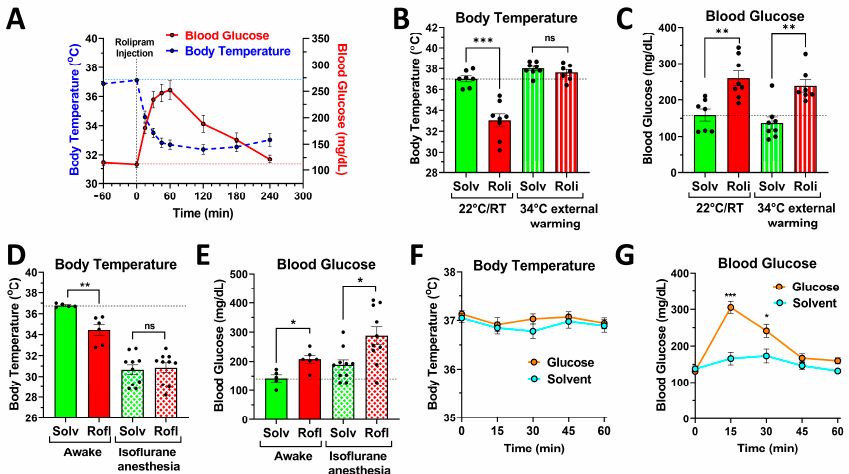
Figure 3. Transient hypothermia and hyperglycemia are independent effects of PAN-PDE4 inhibitor treatment. ( A ) Treatment with a PAN-PDE4 inhibitor induces acute hypothermia, as well as hyperglycemia, on similar time courses. Postprandial mice were injected with the PDE4 inhibitor rolipram (5 mg/kg; i.p.; n = 12) and blood glucose levels (red/solid line) and body temperature (blue/striated line) were measured at the indicated time points. ( B , C ) External warming prevents PDE4 inhibitor-induced hypothermia, but not increased blood glucose levels. After 5 h of food deprivation, mice were acclimated to cages maintained at room temperature (22 °C; solid bars) or to cages externally warmed to 34 °C using an electric heater (striated bars). Mice were then injected with rolipram (Roli; 5 mg/kg; i.p.) or the solvent control (Solv), and body temperature ( B ) and blood glucose levels ( C ) were assessed 30 min later. ( D , E ) Isoflurane anesthesia equalizes body temperatures and locomotion but does not prevent increased blood glucose levels in response to PDE4 inhibitor treatment. Shown are the body temperatures ( D ) and blood glucose levels ( E ) in mice at 30 min after treatment with the PAN-PDE4 inhibitor roflumilast (Rofl; 5 mg/kg; i.p.) or solvent controls (Solv). The effects of drug treatment were compared in awake mice (solid bars) to mice maintained under continuous isoflurane anesthesia beginning at 10 min prior to drug/solvent injection and continued throughout (patterned bars). ( F , G ) Elevated blood glucose levels do not cause hypothermia in mice. After an assessment of baseline body temperature and blood glucose levels, postprandial mice were given glucose (2 g/kg in water; oral gavage (o.g.); n = 10) or the same volume of water (solvent), and body temperature ( F ) and blood glucose levels ( G ) were measured at the indicated time points. All data represent the mean ± SEM. Statistical significance was determined using Mann–Whitney tests (bar graphs) or a two-way ANOVA with Sidak’s post hoc test (time courses) and is indicated as: ns ( p > 0.05); * ( p < 0.05); ** ( p < 0.01); and *** ( p <